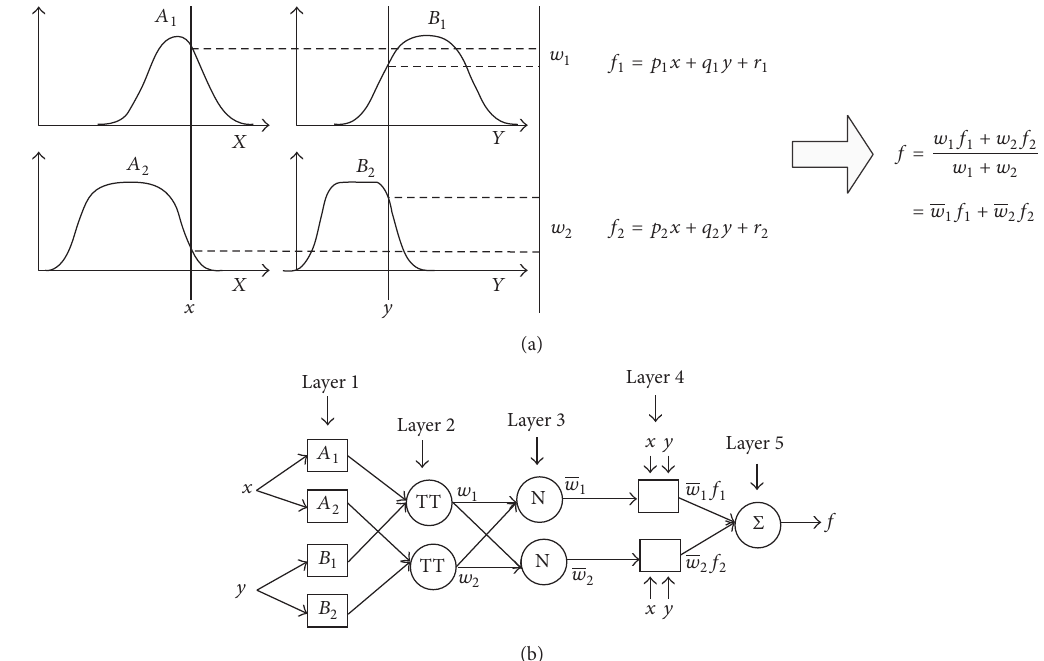
Figure 9: (a) A Sugeno type fuzzy model and (b) its equivalent ANFIS architecture.